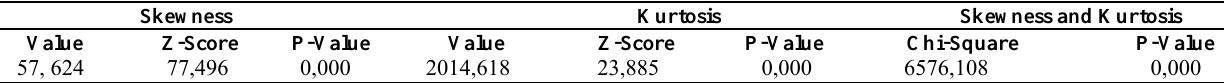
Table 8: Test of multivariate normality for continuous variables Skewness Kurtosis Skewness and